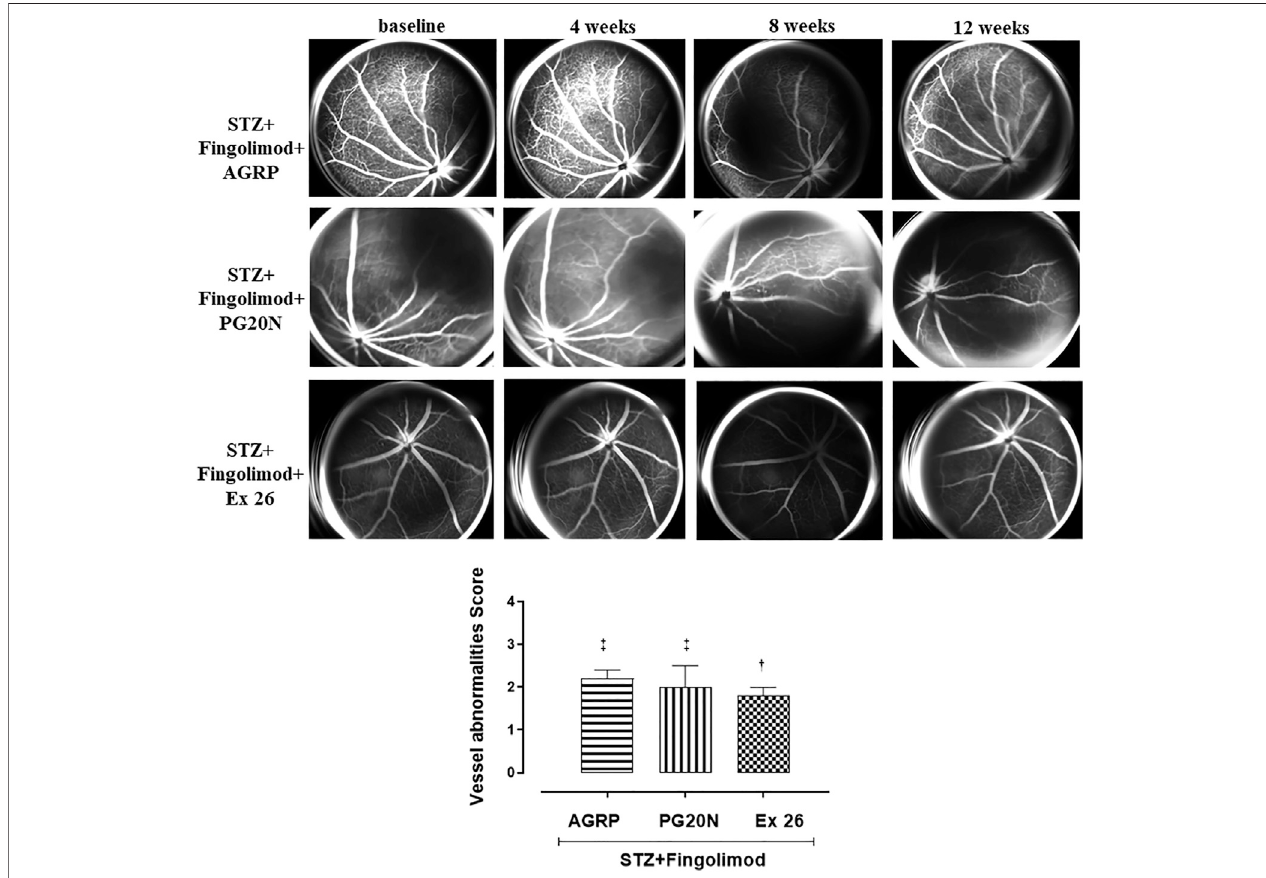
FIGURE 2 | Representative FA images of eyes from diabetic mice treated with Fingolimod and MC1R antagonist (STZ + Fingolimod + AGRP), MC5R antagonist (STZ + Fingolimod + PG20N), and SP1R1 antagonist (STZ + Fingolimod + Ex 26) during the follow-up. The STZ + Fingolimod + AGRP mice showed irregularity of the vessel size, which did not signi fi cantly change over time. The STZ + Fingolimod + PG20N group showed a slight progressive thinning of the vascular caliber during the follow-up. In the STZ + Fingolimod + Ex 26 group, neither the appearance of typical signs of RD nor a signi fi cant variation of the size or of the vascular course was appreciated, during the follow up. Vessel abnormalities score (graded from 0 to 4) was calculated as the average of the vascular alterations observed (N (cid:1) 5 animals per group). Vessel abnormalities were graded from 0 to 4 based on the presence of vessel thinning, tortuosity, venous beading, and rosary-like vessels. Each image represents the same retina of the same mouse but at different time points (at baseline, 4 – 12 weeks of treatment). Statistical signi fi cance was assessed by one-way ANOVA, followed by Tukey ’ s multiple comparison test. † p < 0.05 vs STZ; ‡ p < 0.05 vs STZ + Fingolimod.